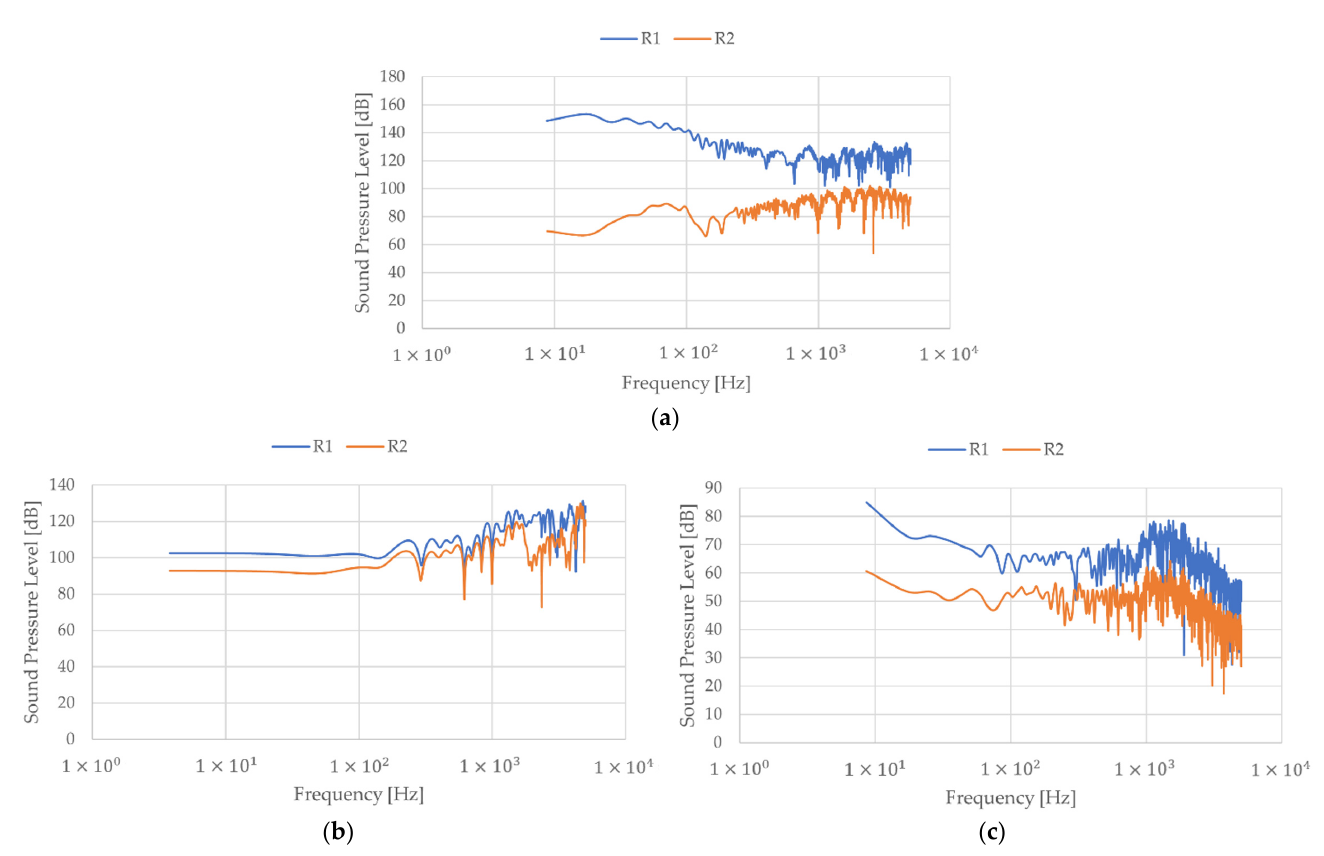
Figure 9. Sound pressure levels of ( a ) three blades, ( b ) four blades, and ( c ) five blades.